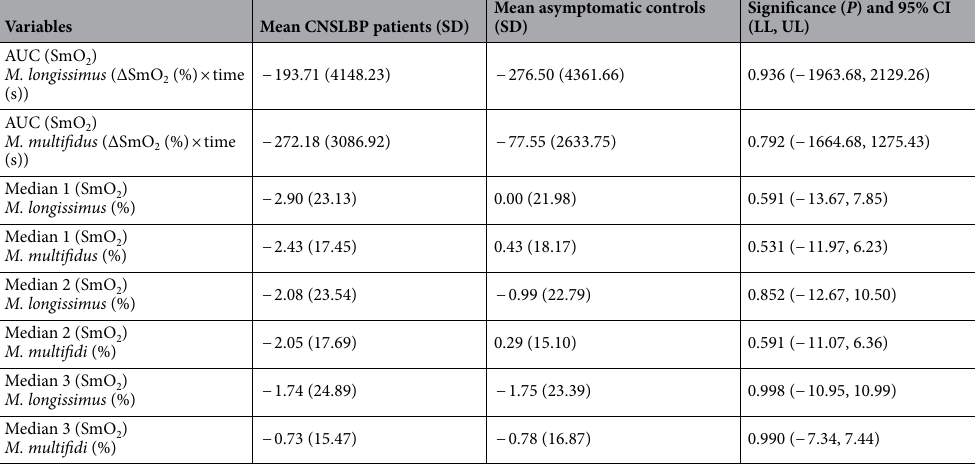
Table 3. Results of the unpaired t-tests of the unstandardized residuals (corrected SmO 2 ) for area under the curve (AUC) and medians of NIRS measurements of M. longissimus and M. multifidus in chronic nonspecific low back pain subjects (CNSLBP) and asymptomatic controls. Displayed are the mean, significance and 95% confidence intervals, lower limit (LL) and upper limit (UL).